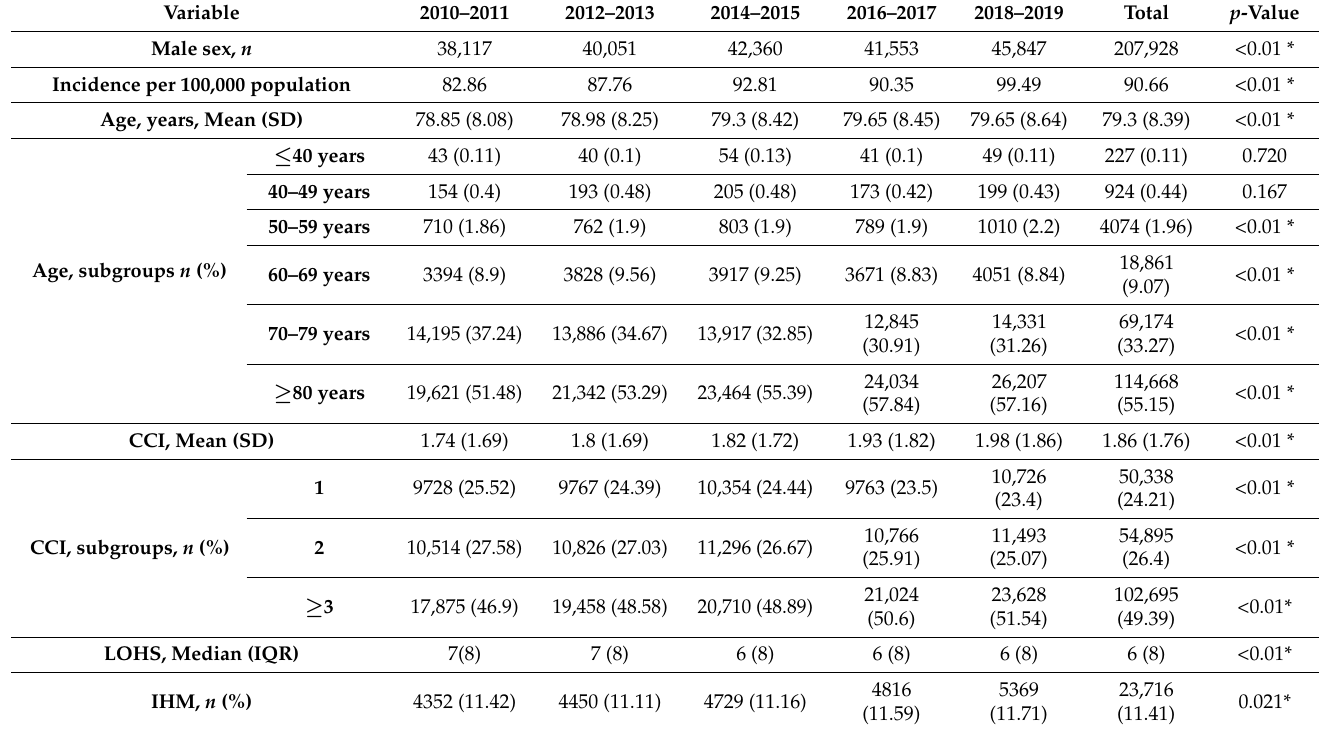
Table 4. Characteristics of Hospital Admissions of Male Patients with Parkinson’s Disease as a Secondary Diagnosis in Spain (2010–2019).